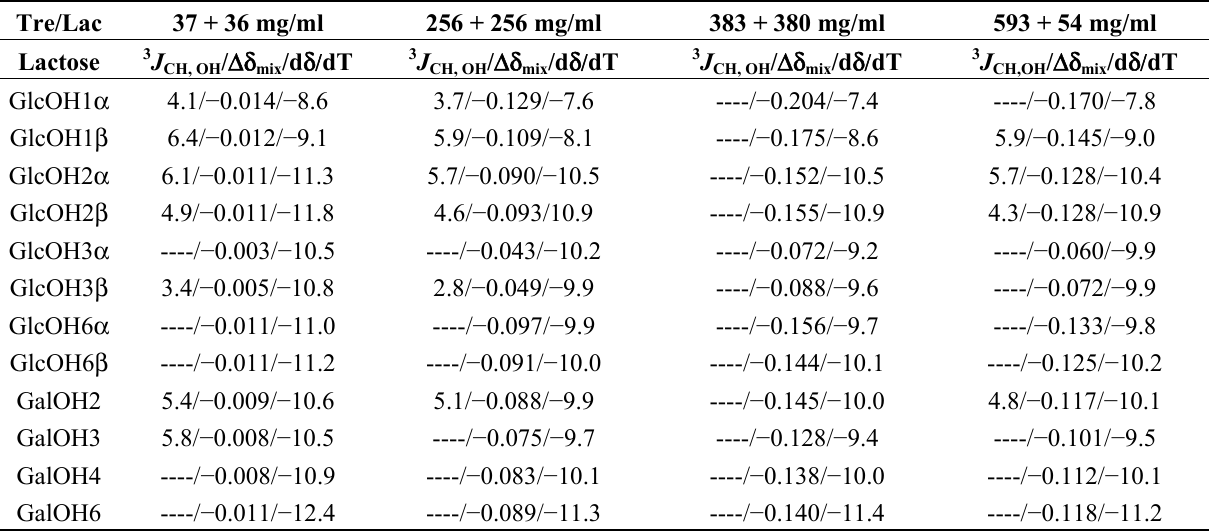
mixtures. All coupling constants could not be extracted due to broad signals and/or